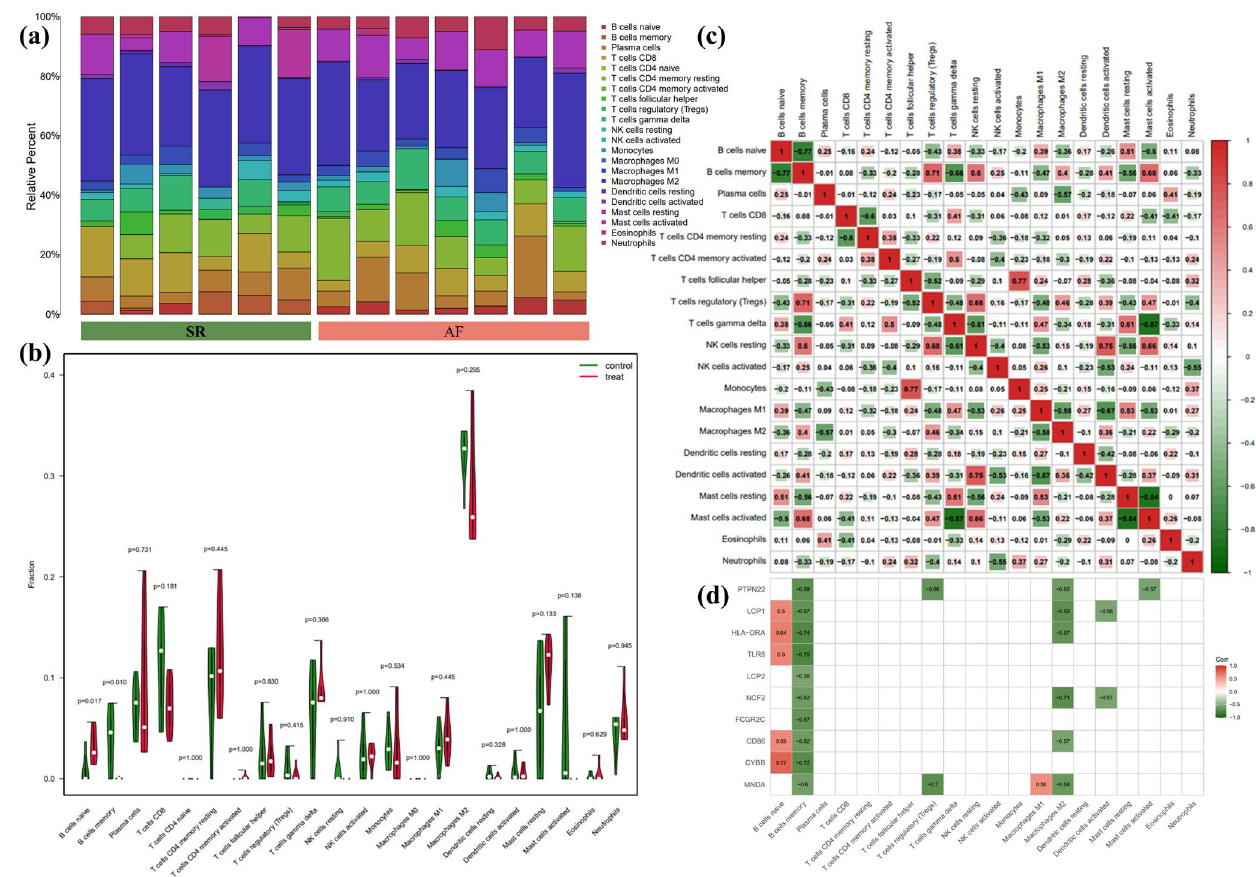
Figure 6. Results of CIBERSORT analysis of GSE79768 (AF-related array). ( a ) Cumulative histogram of immune cell infiltration. ( b ) Violin diagram of immune cell proportions in two groups. Green and fusiform fractions on the left, SR group; red and fusiform fractions on the right, AF group. ( c ) Correlation matrix of infiltration degree of immune cells. Red, positive correlation between two immune cells; blue, negative correlation between two immune cells. The bigger size of the numbers statistics data, the more positive or negative correlation. ( d ) Correlation matrix of infiltration degree of immune cells and hub genes. Red, positive correlation between two immune cells; blue, negative correlation between two immune cells.